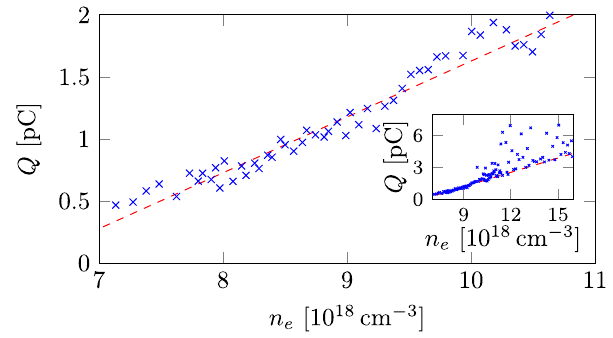
FIG. 5. Charge, above 40 MeV, as a function of electron number density in the peak. The positions of the two nozzles are kept fixed and the electron number density in the plateau is kept constant at 3 . 25 × 10 18 cm − 3 . At low peak densities, the amount of injected charge increases linearly with only small shot- to-shot fluctuations (standard deviation of 0.09 pC) around the fitted line (red dashed). At densities above 10 × 10 18 cm − 3 (shown in the inset), large fluctuations occur. However, the fluctuations only contribute to an increase in the total charge and indicate two different mechanisms of injection. The onset of the large fluctuations coincides with the electron number density threshold for